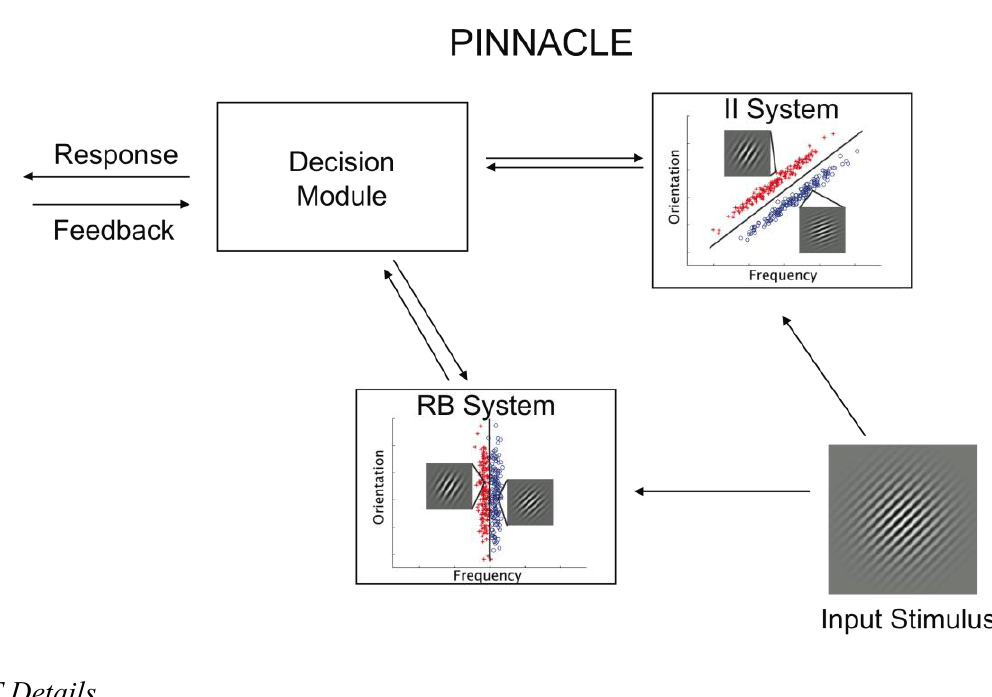
Figure 2. Schematic of the PINNACLE computational model and the accompanying free parameters. Stimulus information is fed into the RB and II systems and evaluated separately. A categorical decision is made within each system, but the decision node adjudicates between the systems according to their relative confidence levels. After a response is made, feedback returns to the system that made the response, and in the case of negative feedback, the representation is